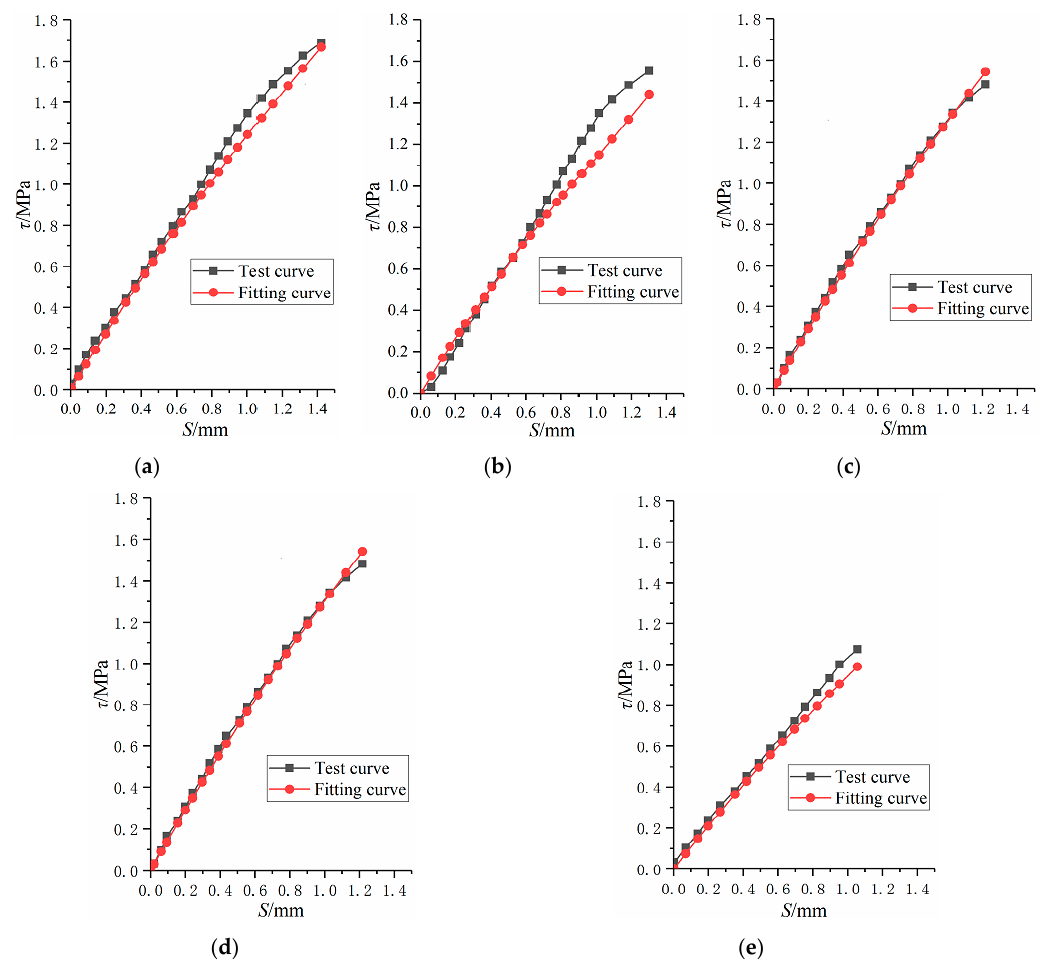
Figure 14. Comparison fitting curve with test curve. ( a ) SRC-2; ( b ) SRC-3; ( c ) SRC-4; ( d ) SRC-5; ( e ) SRC-6.